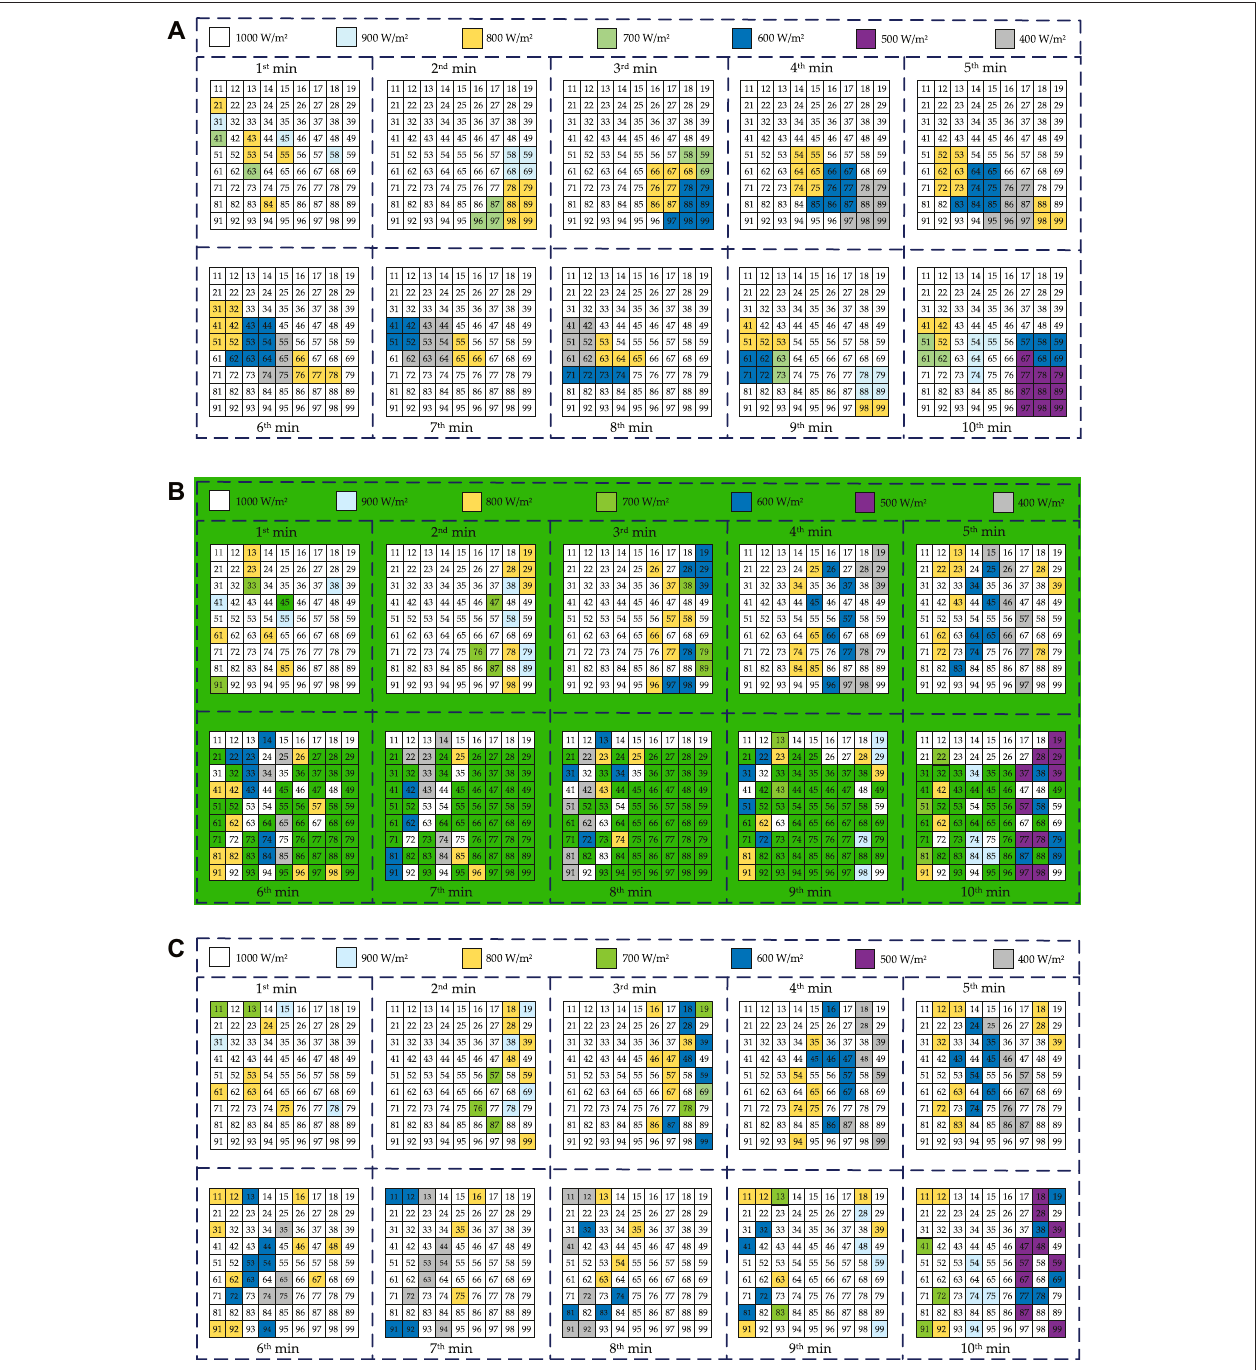
FIGURE 3 | Irradiance distribution of PV array before and after recon fi guration: (A) shadow distribution for every sub-system of PV station with ESS, (B) optimal shadow distribution under constant FR signals obtained by MHHO and (C) optimal shadow distribution under time-varying FR signals obtained by MHHO.